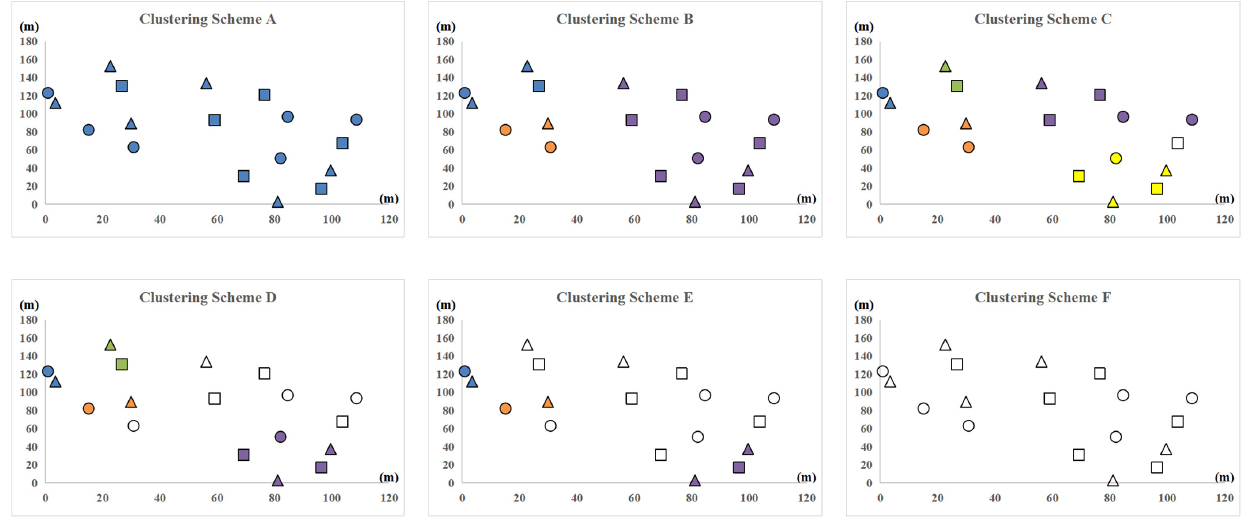
Figure 6. Building groups under different clustering schemes.